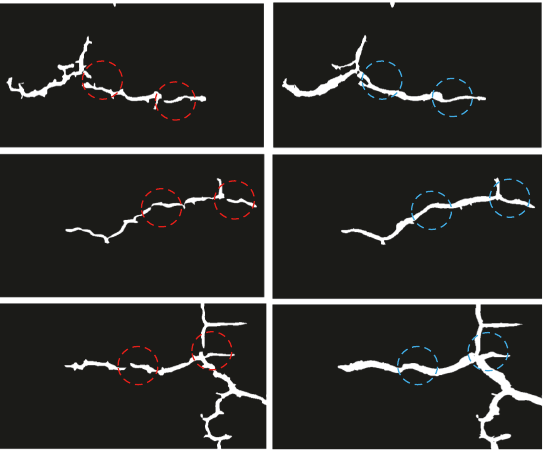
Figure 9: Examples of TV approach: the size of each patch is 700 × 300 pixel 2 . The patches in the left column are cropped from the crack saliency maps; the patches in the right column are cropped from the results of TV